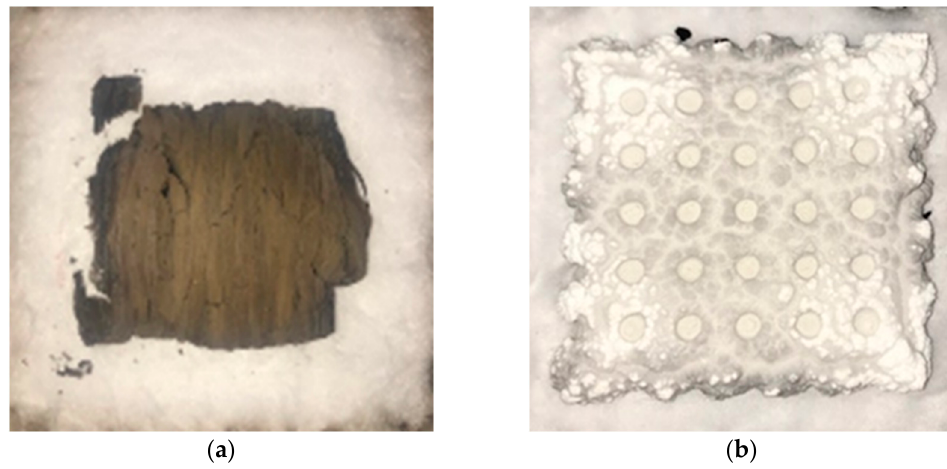
Figure 3. Residue of ( a ) wood and ( b ) thermoplastic samples after combustion.